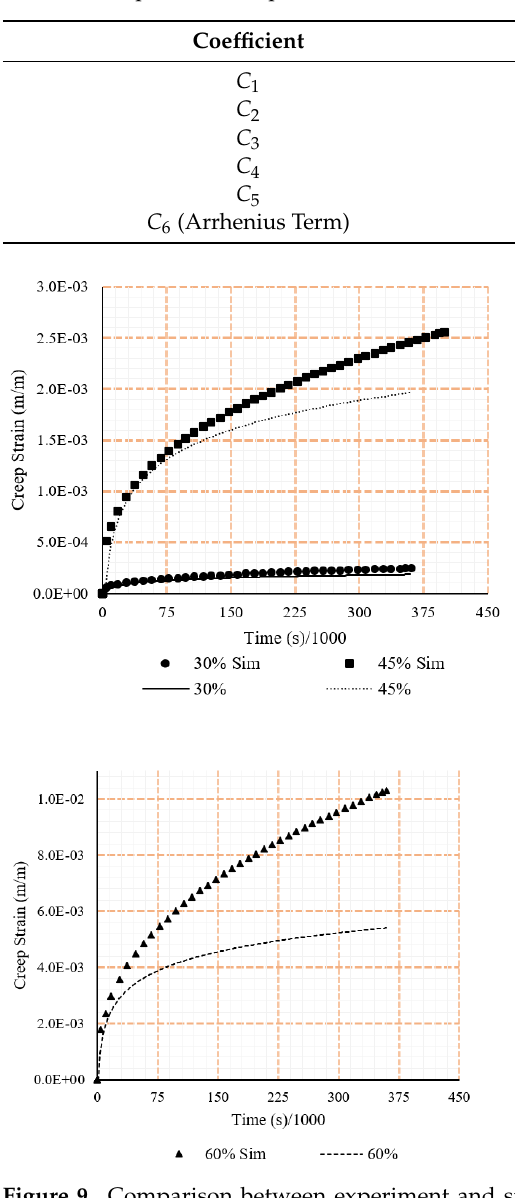
Figure 9. Comparison between experiment and simulation compressive strains under dif- ferent loading rations (ratio of sustained load to the ultimate